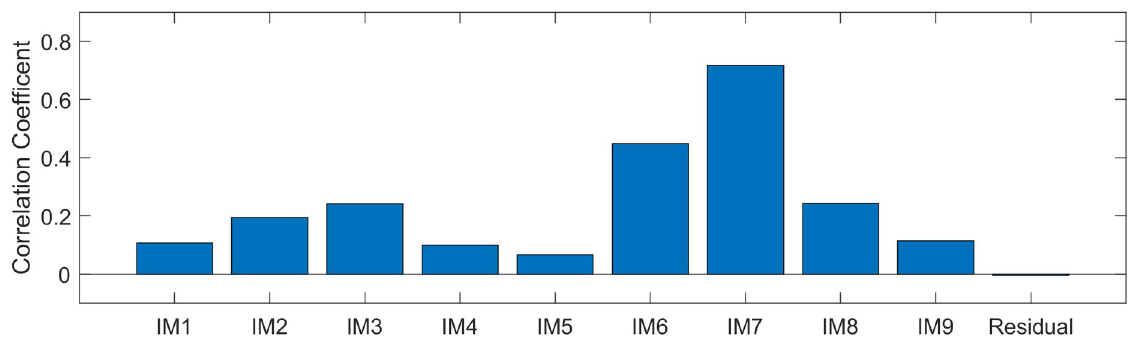
Fig 7. The correlation coefficient of IMFs and